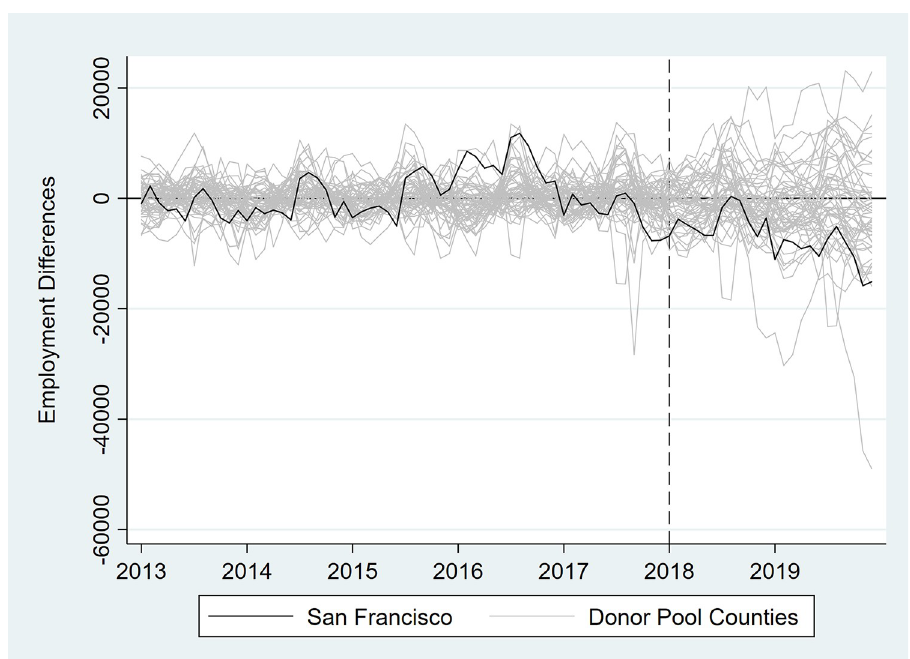
Fig 8. Differences in employment outcomes between each county and its synthetic control for private sector employment.